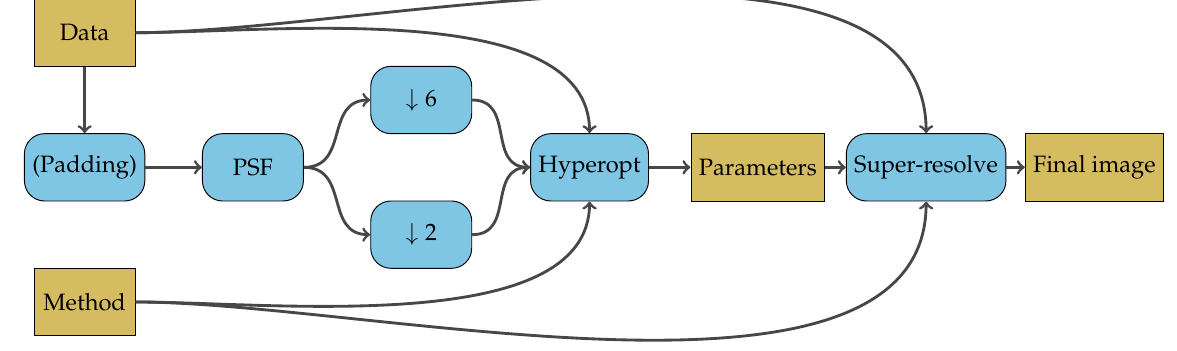
Figure 2. Flow graph showing the parameter tuning process. Scale reduced data is super-resolved back to its original resolution and evaluted against the unscaled data for parameter selection. The parameters are then used to super-resolve the unscaled data to 10 m